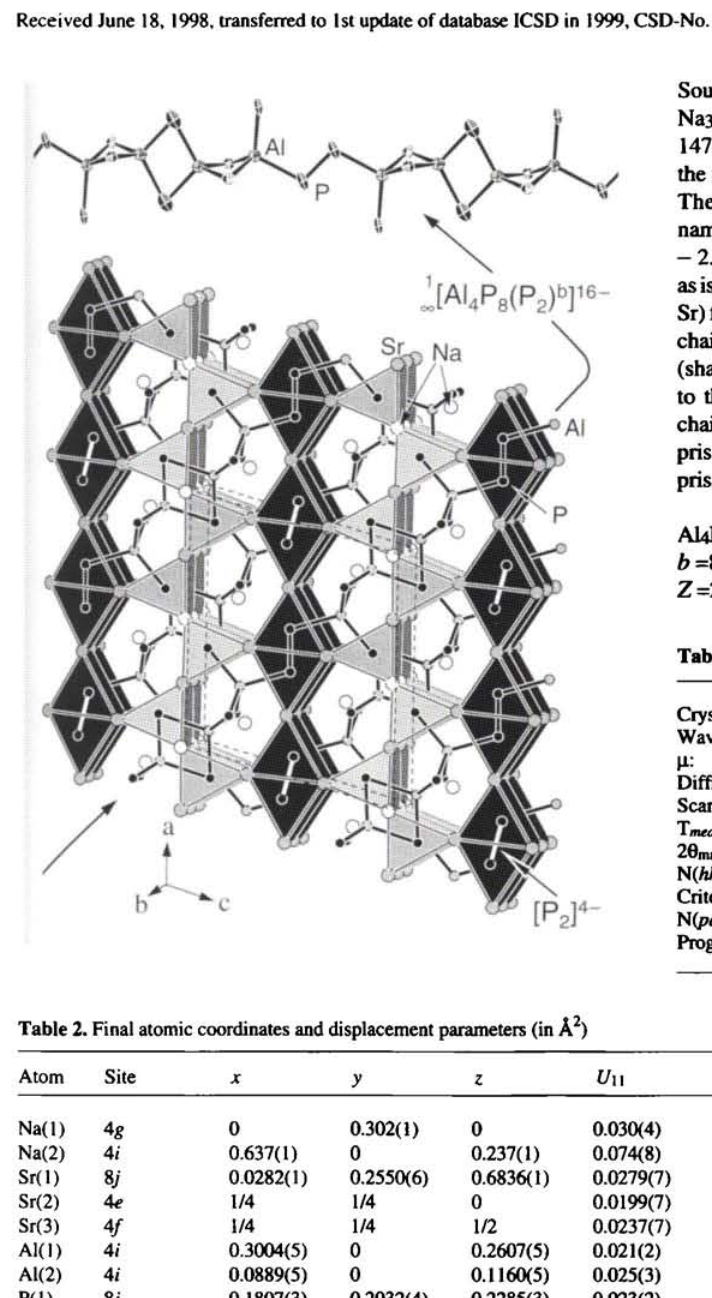
Table 2. Final atomic coordinates and displacement parameters (in Â^)